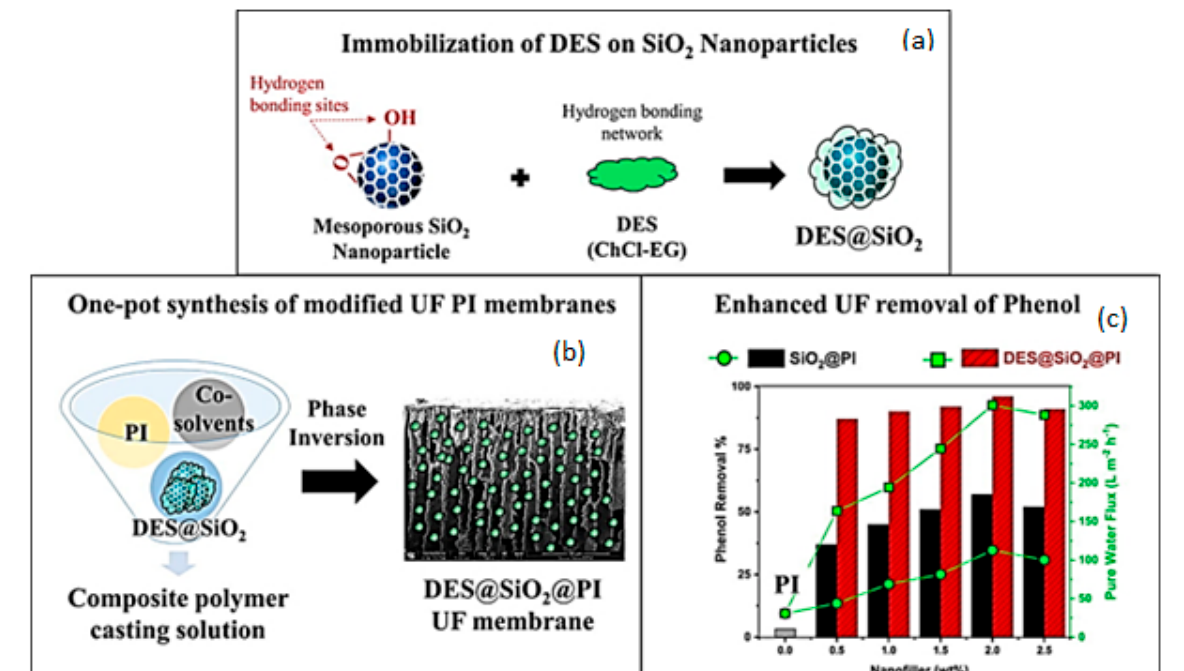
Figure 16. ( a ) Doping of choline chloride–ethylene glycol (ChCl-EG) onto silica (SiO 2 ) particles, ( b ) incorporation of DES-doped silica nanoparticles in polyimide UF membranes and ( c ) their performance in filtration of phenol solutions [80].